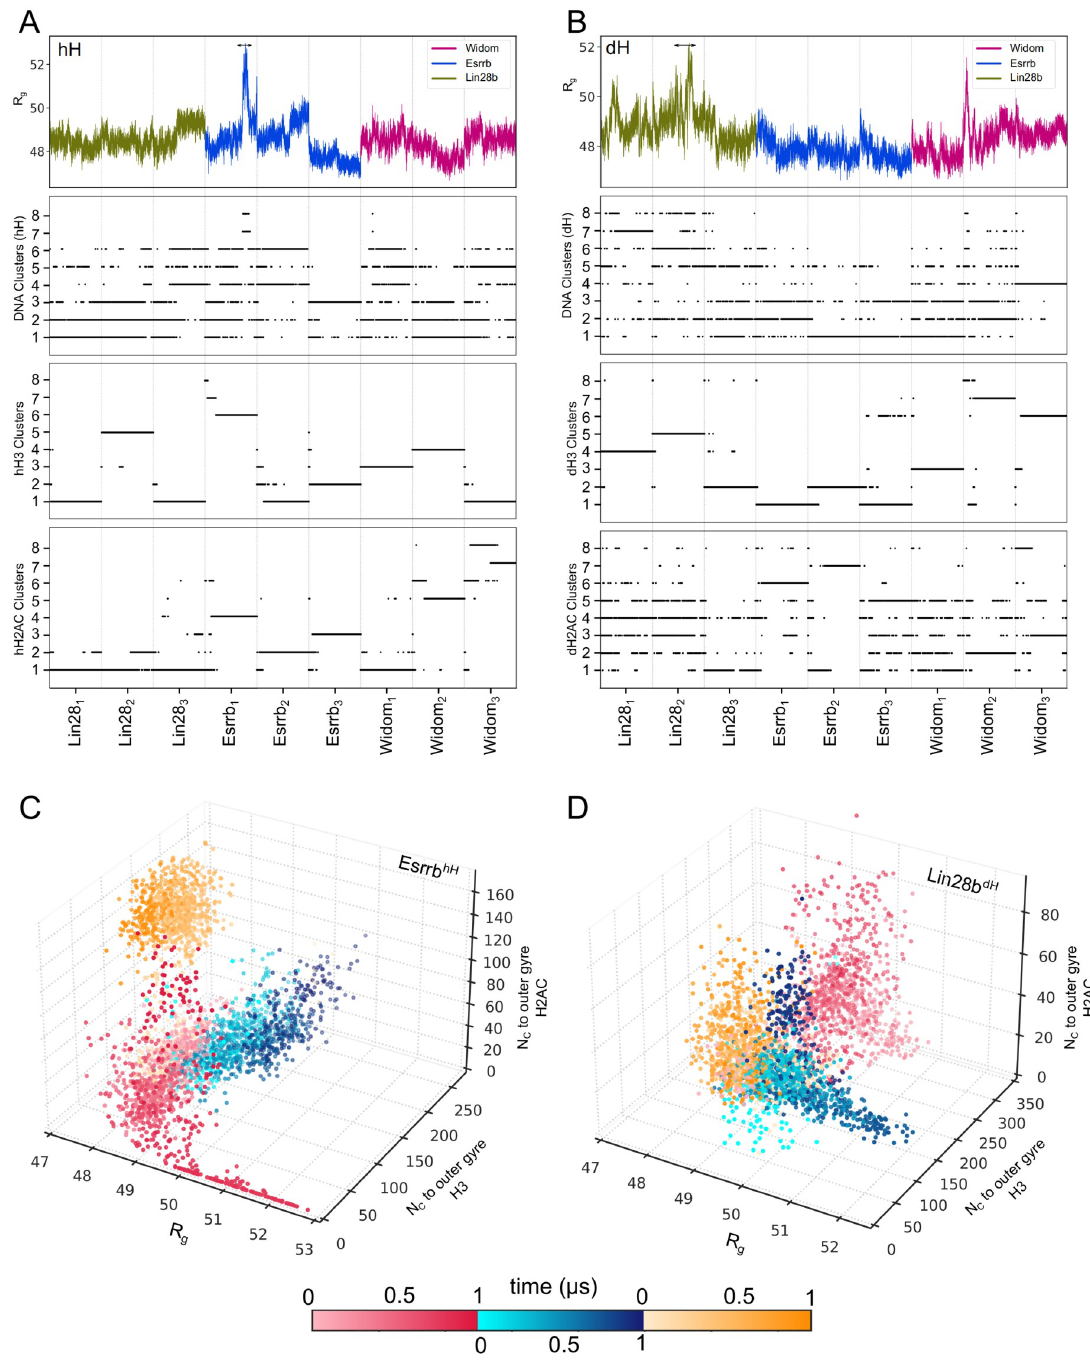
Fig 7. Correlated structural transitions in the nucleosomes. Structures from each DNA, H3, and H2AC cluster mapped on the simulation time series. (A) The 3’ end of the hH nucleosomes. (B) The 5’ end of the dH nucleosomes. In each panel, the top plot shows the nucleosome R g and the 3 plots below show to which DNA, H3, and H2AC clusters each simulation snapshot belongs to. Each point corresponds to one single snapshot. (C-D) Scatter 3D plots depicting the correlation between the conformations of Esrrb hH (C) and Lin28b dH (D) and the number of contacts of the H3 and H2AC tails with the outer DNA gyre during the individual simulations (red, blue, yellow). The light to dark color palette shows the simulation time.